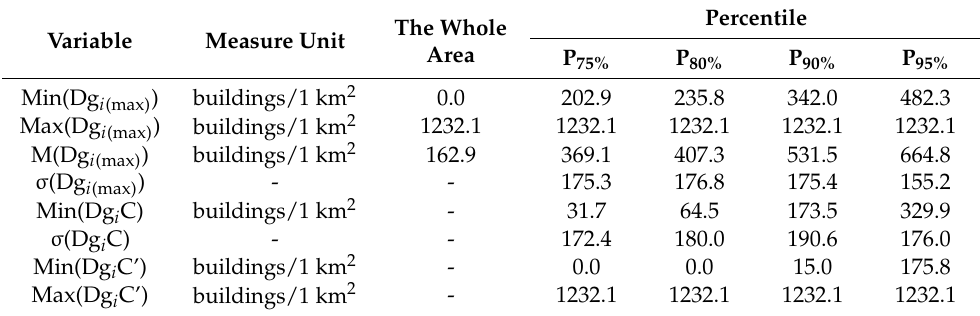
Table 2. Statistics on the building density of squares, excluding extreme values.